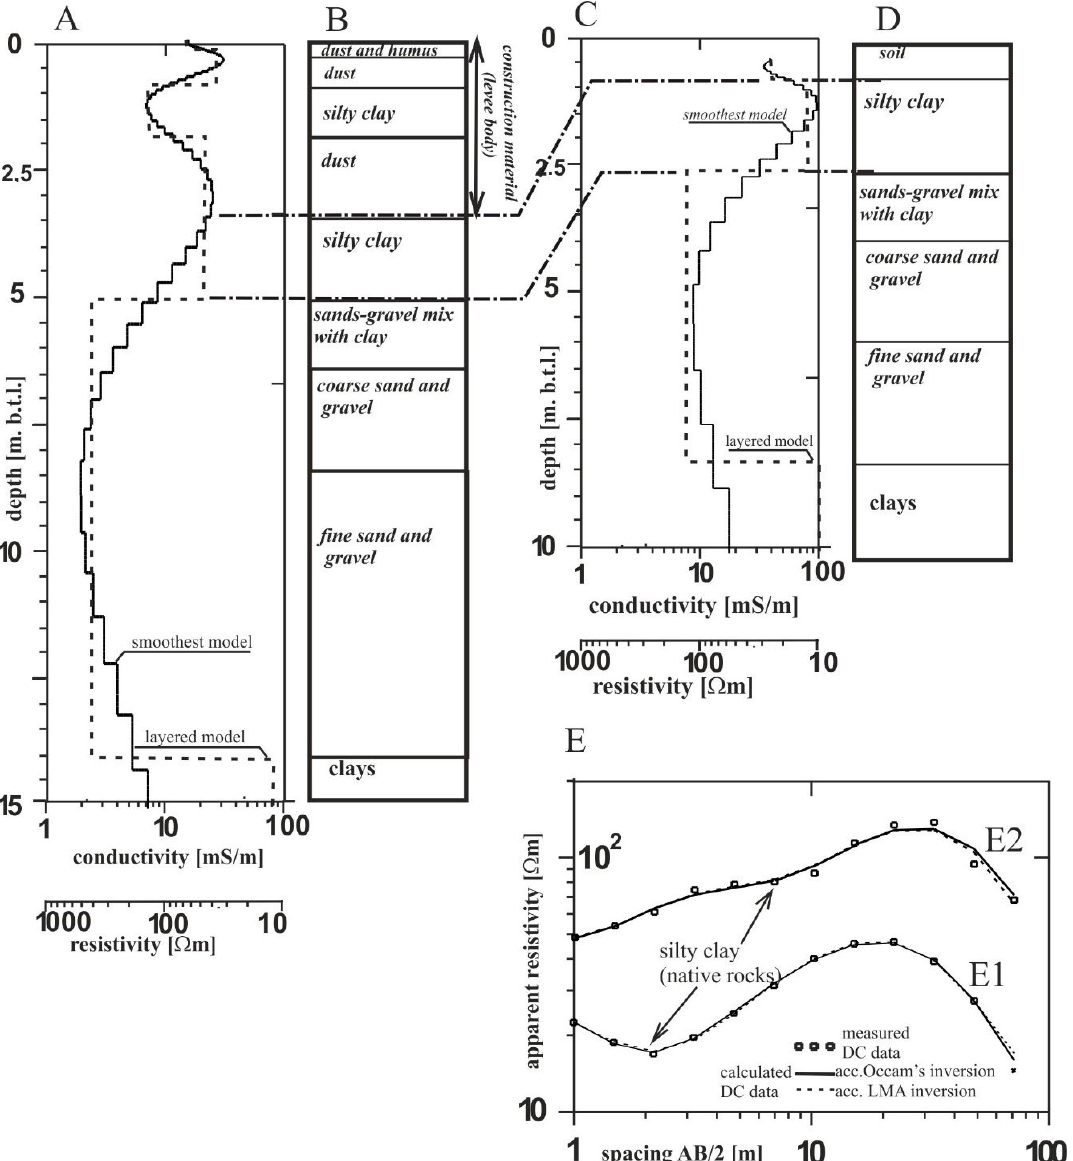
Figure 4. Results of an interpretation of location No. 1 (Figure 1) incorporating both the DC and GCM soundings and using IX1D software, A —geoelectric models obtained from the DC resistivity soundings, B —conductivity section of the DC data (for short array profiling), C —geoelectric models obtained from the GCM soundings, D —conductivity section of the GCM data (for short array profiling), E —borehole data, F —fit between the measured DC data and calculated DC data, G —fit between the measured GCM data and calculated GCM data. Correlation of the silty clay layer identified by the DC sounding and GCM sounding No. 1 ( ).